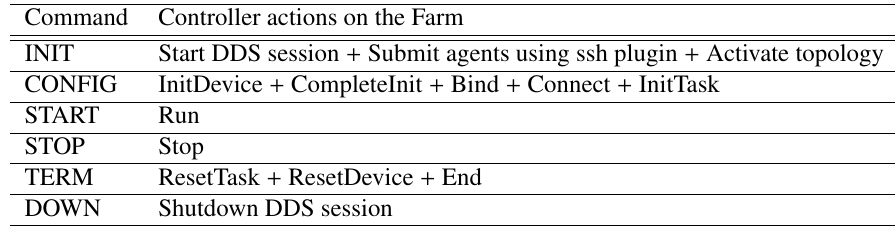
Table 1. Experiment control command mapping to FairMQ states